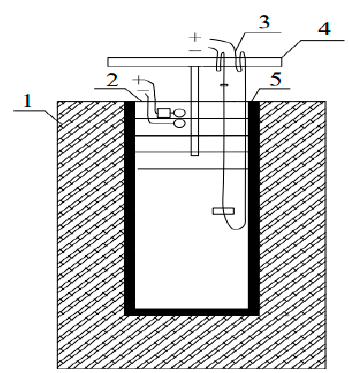
Figure 1. Icing Simulation Device ( 1 ) Expanded Polystyrene (EPS) insulation. ( 2 ) Heating sheet. ( 3 ) Device for measuring ice thickness. ( 4 ) T-bracket. ( 5 ) Glass cylindrical barrel.